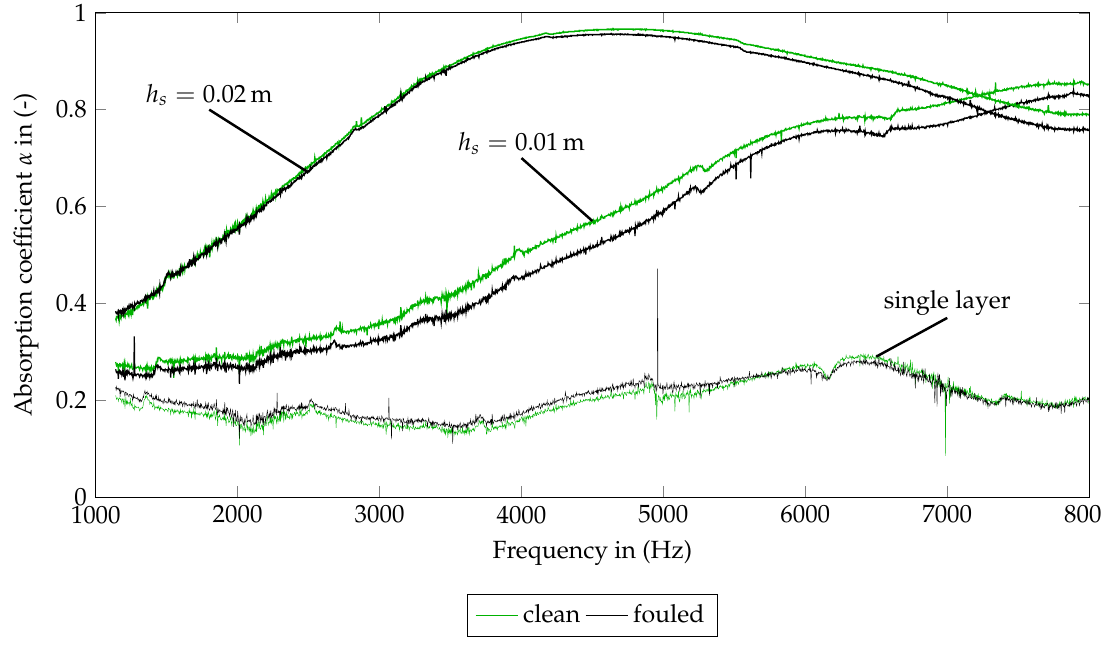
Figure 6. Measured frequency-dependent absorption coefficients of clean (0 M) and fouled (12 M) SFF 150 for one layer and staple sizes of 0.01m and